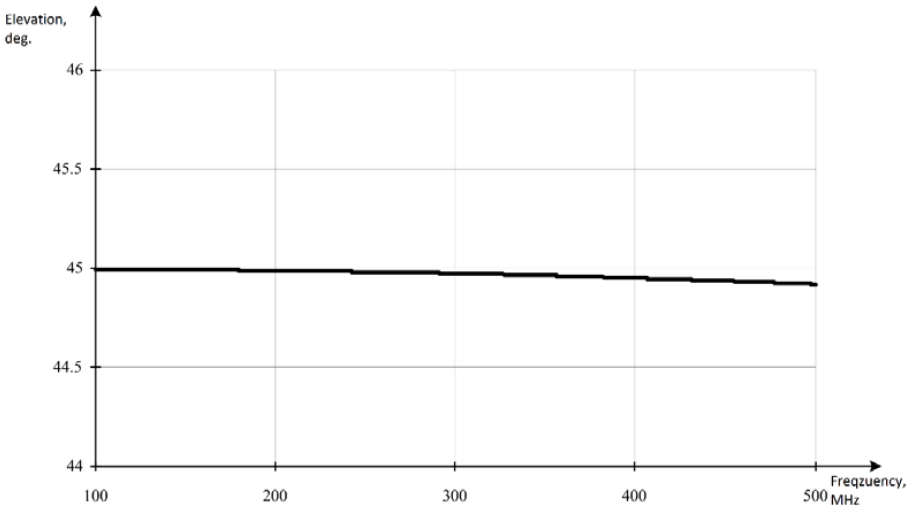
Figure 27. Calculated elevation angle of the source in the frequency band from 100 to 500 MHz (the true elevation angle is 45 degrees).